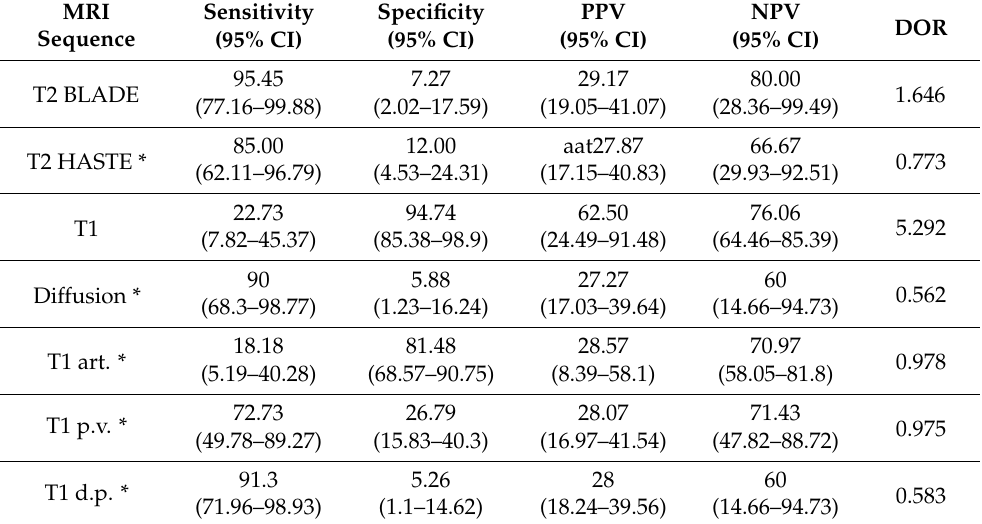
Table 5. Diagnostic accuracy of MRI signal characteristics for a local tumor progression in the peripheral part of the ablation area after IRE of an HCC.